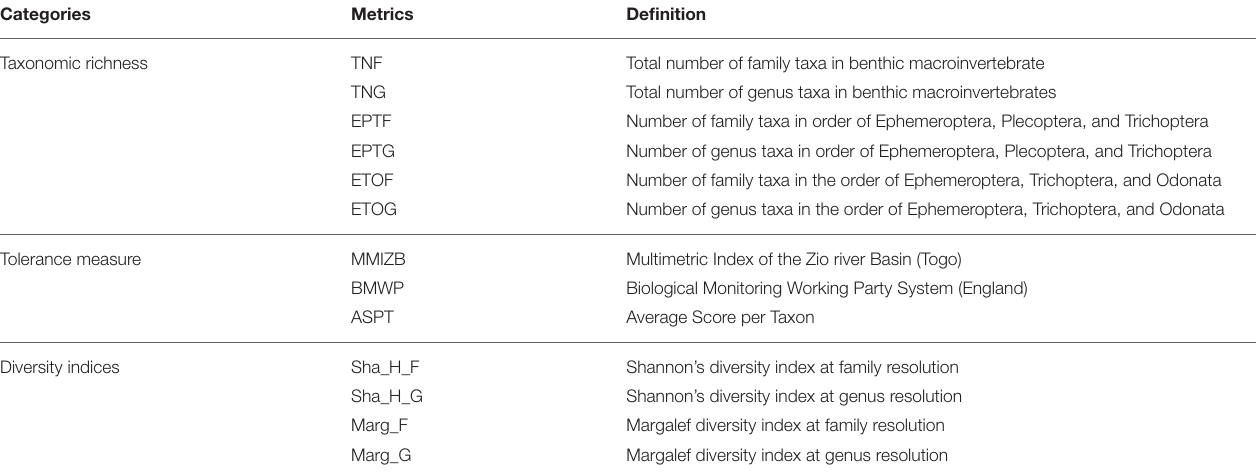
TABLE 1 | Selected metrics and their